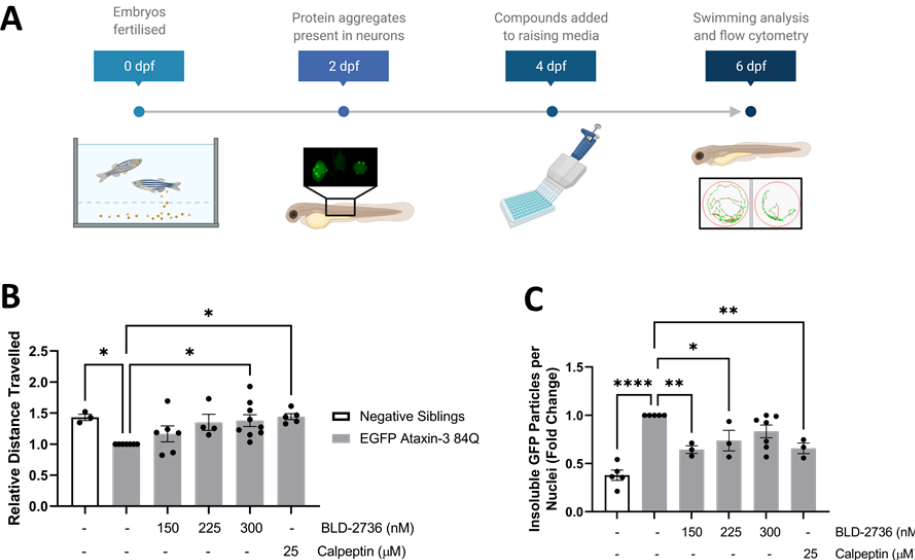
Figure 3. Delayed treatment with BLD-2736 or calpeptin produced a therapeutic benefit, despite administration after the onset of disease pathology. ( A ) Timeline displaying the onset of disease pathology at 2 dpf, treatment administration at 4 dpf, and examination of treatment efficacy at 6 dpf. ( B ) Treatment of SCA3 zebrafish from 4 to 6 dpf improved the distance swum when compared to vehicle treated SCA3 zebrafish. Swimming analysis was performed on n = 12 – 25 larvae per group. ( C ) Post-symptomatic treatment with calpain inhibitors produced a detectable decrease in the presence of detergent-insoluble EGFP-fused ataxin-3 particles. Each data point represents an experimental replicate, where n = 12 – 20 larvae were pooled together. All data are presented as mean ± SEM. * represents p < 0.05, ** represents p < 0.01, **** represents p < 0.0001.